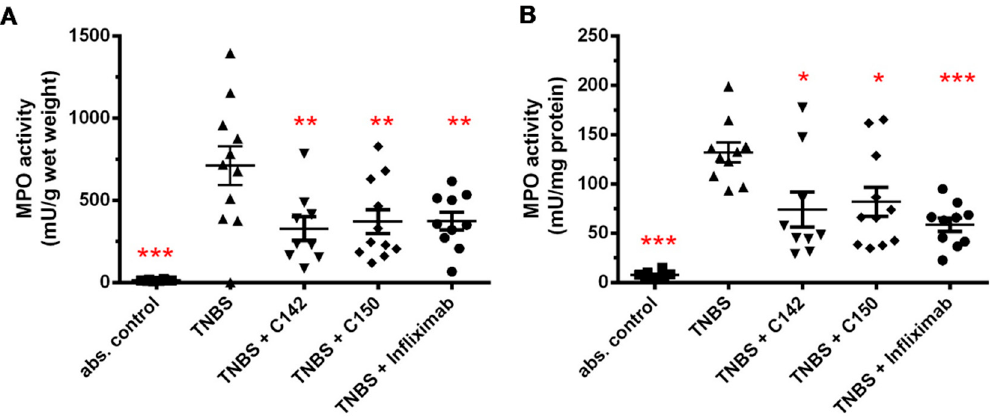
Figure 6. Effects of curcumin analogues on total tissue myeloperoxidase (MPO) activity (mU) normalized to ( A ) wet weight (grams) of the tissue or ( B ) protein content (mg) in the sample. MPO enzyme activity was significantly decreased both by C142 and C150 Mannich curcuminoids. MPO activity was measured as described in Section 4.6 of Materials and Methods. Results are shown as mean ± S.E.M.; n = 8–11; * p < 0.05, ** p < 0.01, *** p < 0.001 pair-wise comparison with TNBS-treated